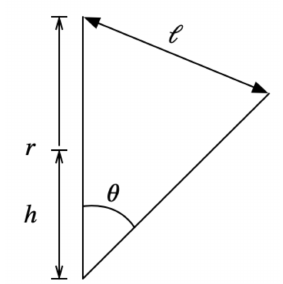
Figure 3. An illustration of the bending of a stem of length r to create a line segment of length (cid:96) . The half-height, where the measuring device contacts the stem, is a distance h above the ground, and the final angle of bending is denoted as θ